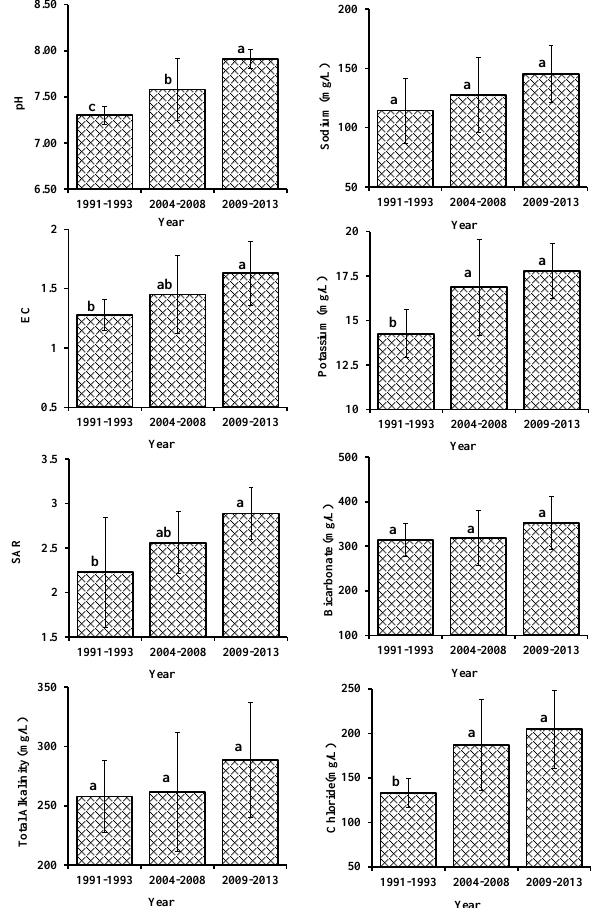
Figure 3: The observed trend in selected water quality parameters from 1991-2013. Water samples were obtained from well sources utilized by a golf course in Lubbock, Texas, Figure 3. The observed trend in selected water quality parameters USA. For each parameter, data were averaged over 1991-1993 (n = 9), 2004-2008 (n = 6) and from 1991 to 2013. Water samples were obtained from well sources 2009-2013 (n = 6), error bars are for the standard deviations. Mean values within a parameter utilized by a golf course in Lubbock, Texas, USA. For each pa- with the same letter are not statistically different (Fisher's LSD, α = 0.05). rameter, data were averaged over 1991–1993 ( n = 9), 2004–2008 ( n = 6), and 2009–2013 ( n = 6); error bars are for the standard de- viations. Mean values within a parameter with the same letter are not statistically different (Fisher’s LSD, α =